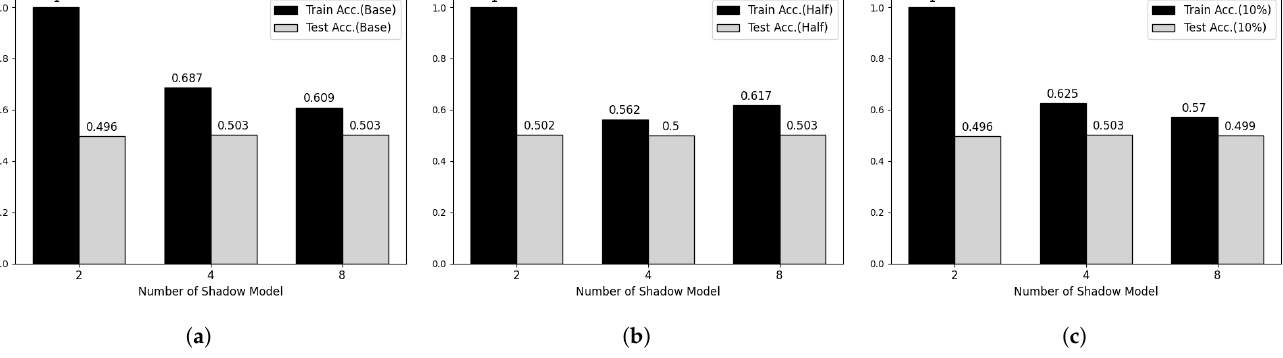
Figure 6. Membership inference attack results on Fashion-MNIST datasets. ( a ) Base Model. ( b ) Half-data trained Model. ( c ) 10%-data trained Model.